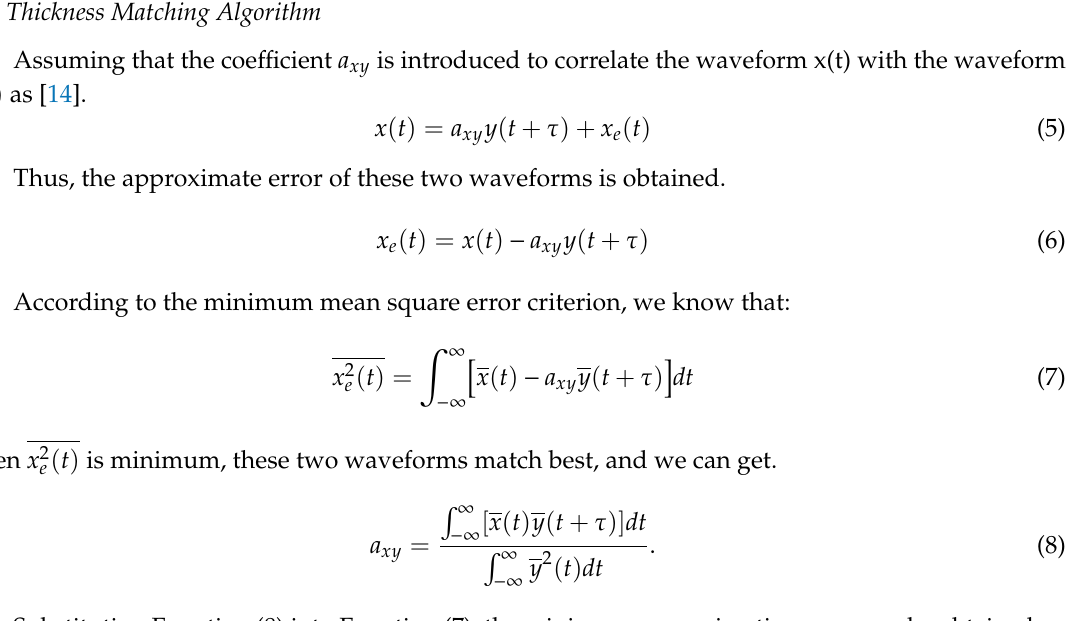
Figure 2. System composition of an ultrasonic measurement model.